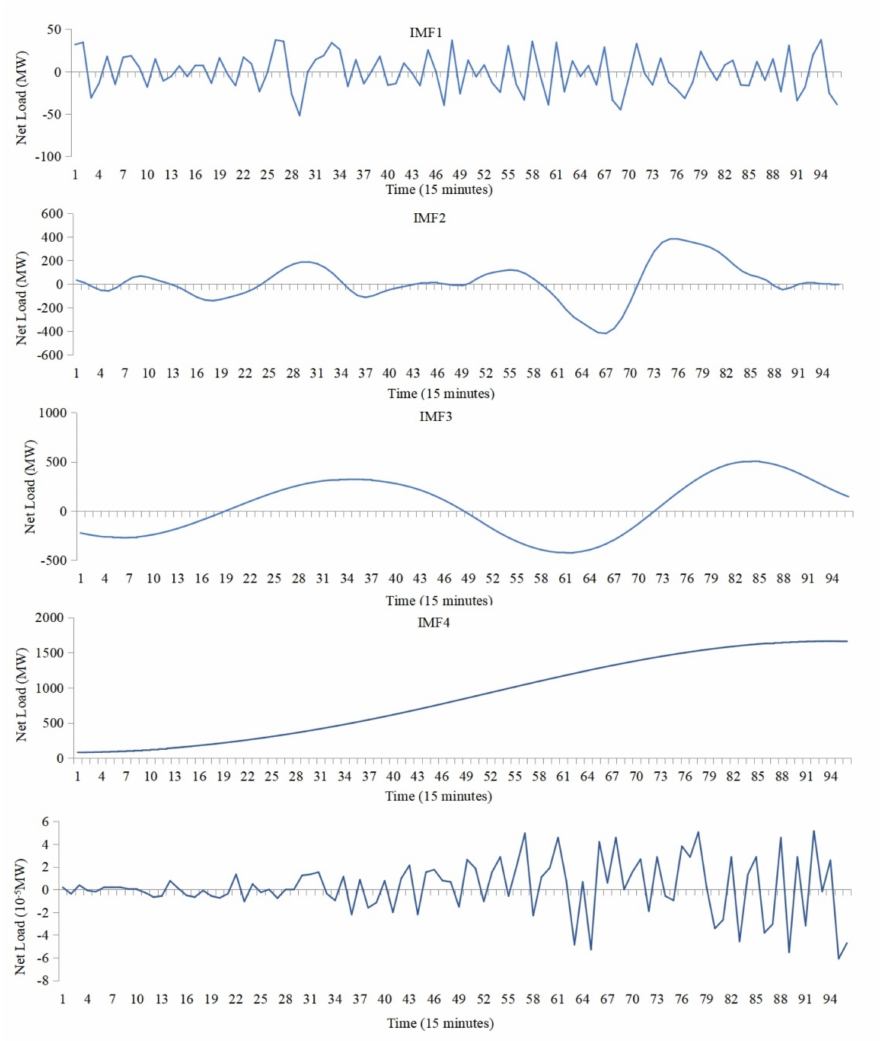
Figure 5. The IMF components and margin of the net